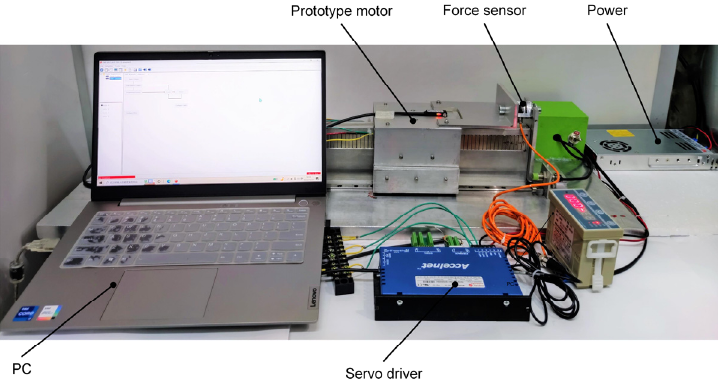
Figure 17. The electromagnetic thrust test platform of the prototype.